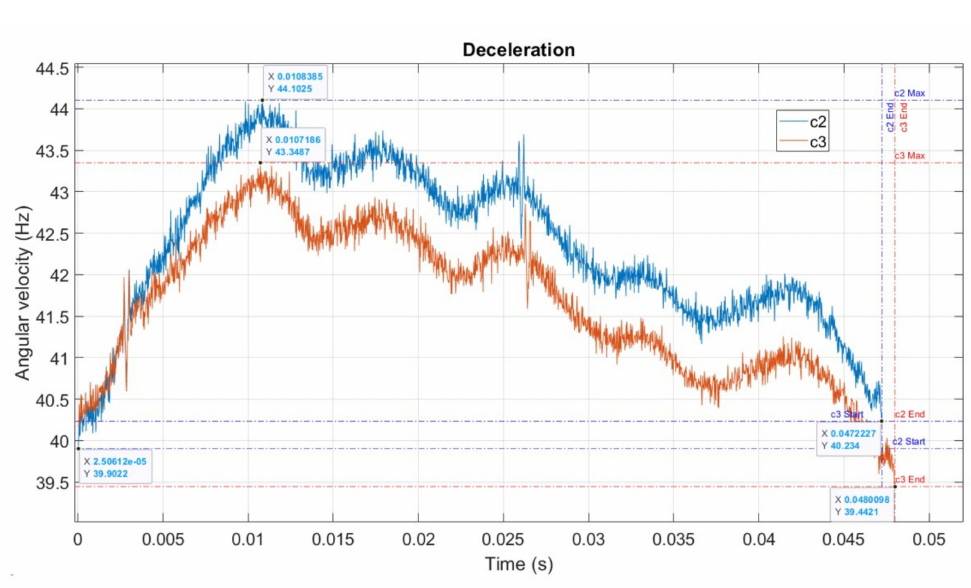
Figure 18. Cycles 2 and